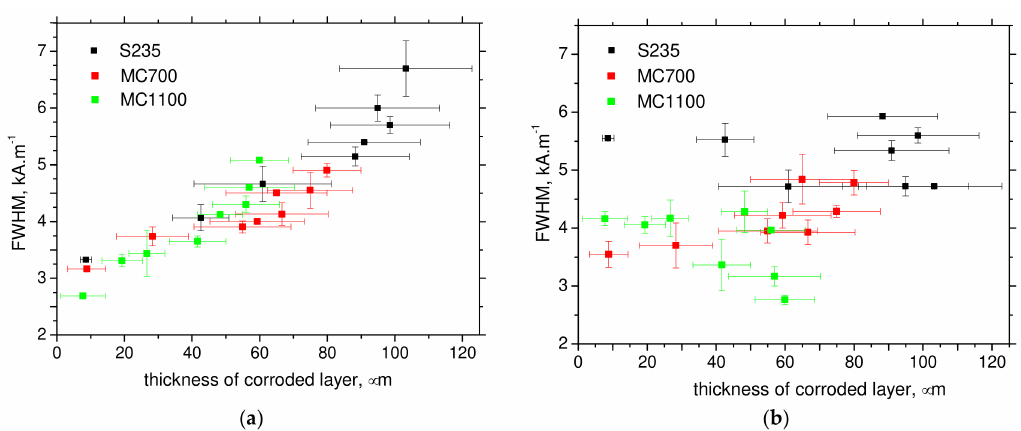
Figure 10. Thickness of corroded layers versus MBN (rms). ( a ) RD, ( b ) TD.